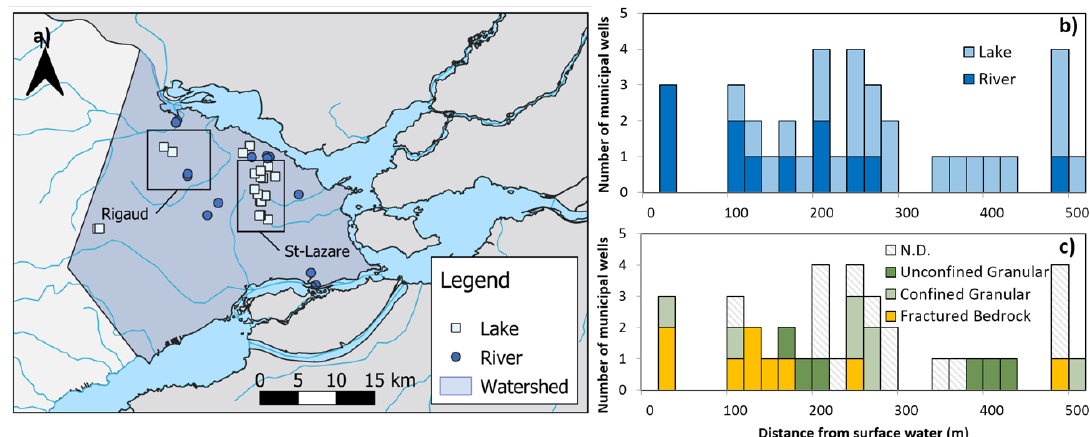
Figure 7. ( a ) The spatial distribution of municipal wells located at less than 500 m from lakes and rivers in area #3 and the distribution of wells according to ( b ) the type of surface water and ( c ) the type of aquifer.